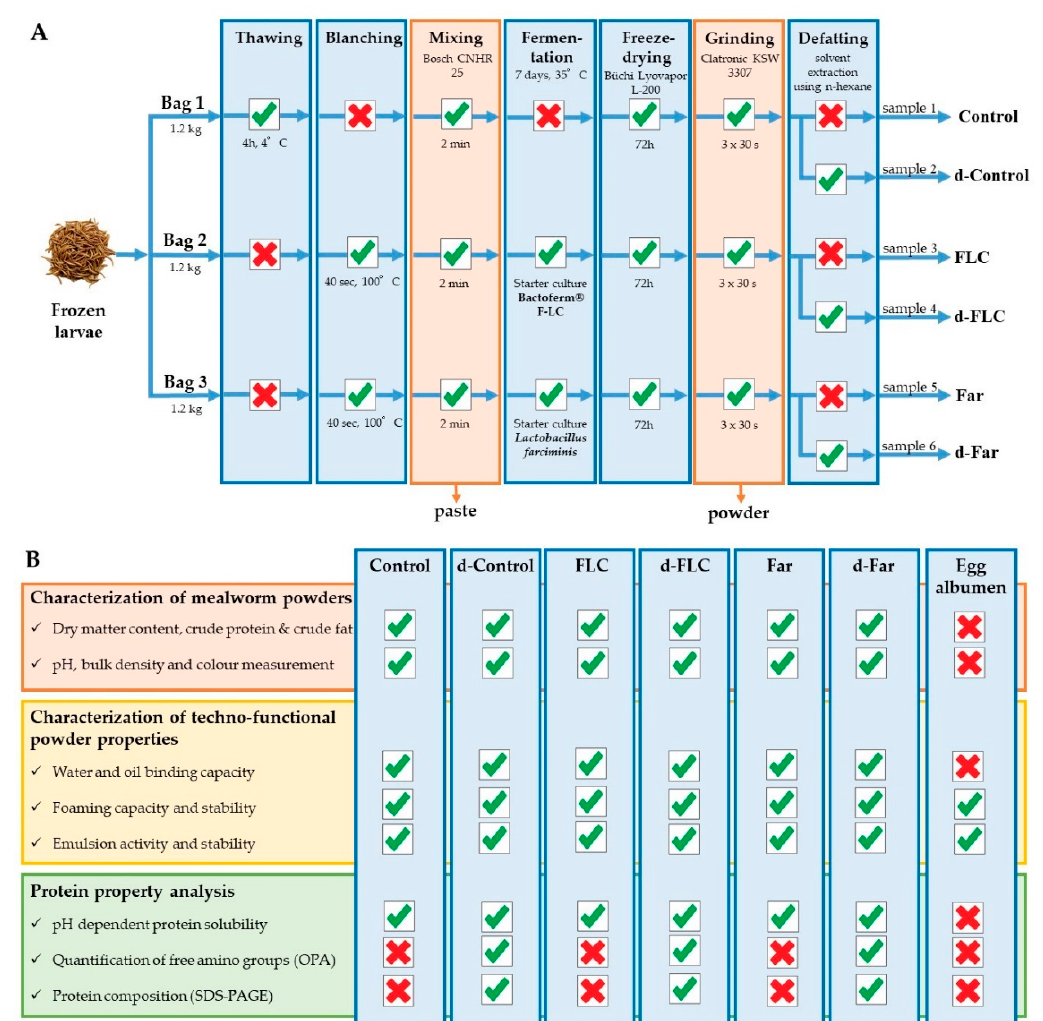
Figure 1. Schematic representation of sample preparation ( A ) and an overview of the performed analyses ( B ).